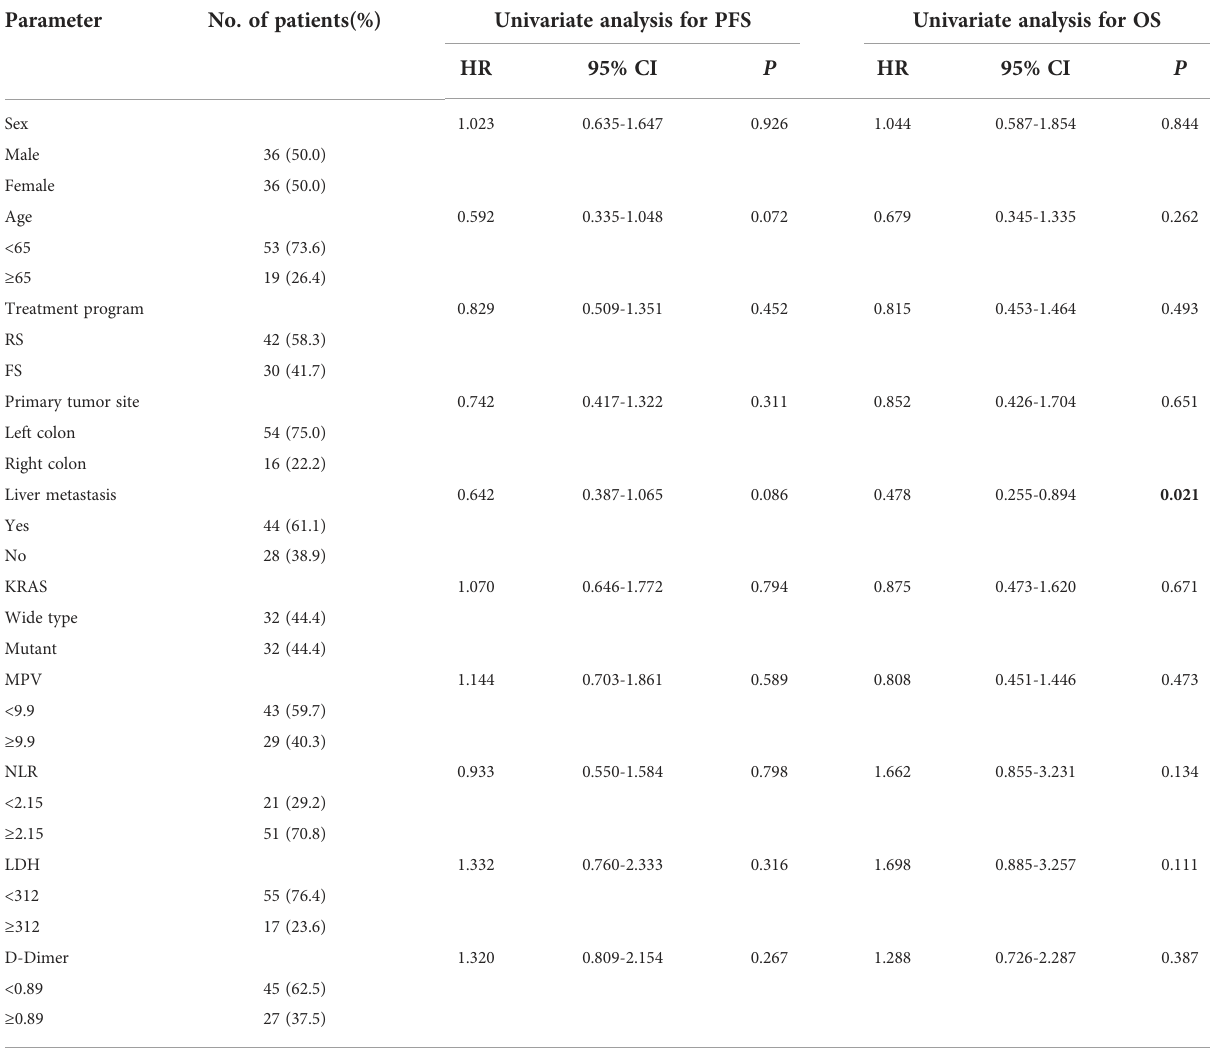
TABLE 3 Exploratory univariate analysis of factors to predict PFS and OS.